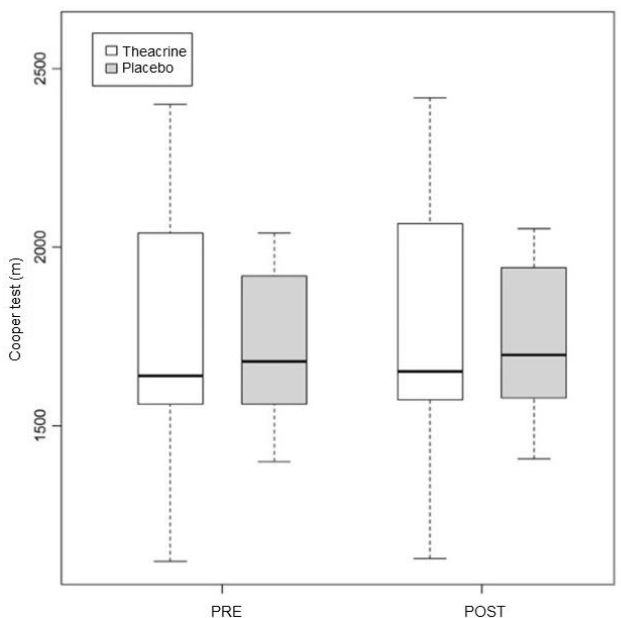
Figure 6. Alterations in performance in the Cooper test in the first and second assessments. Values expressed in median – interquartile interval. M = meters.